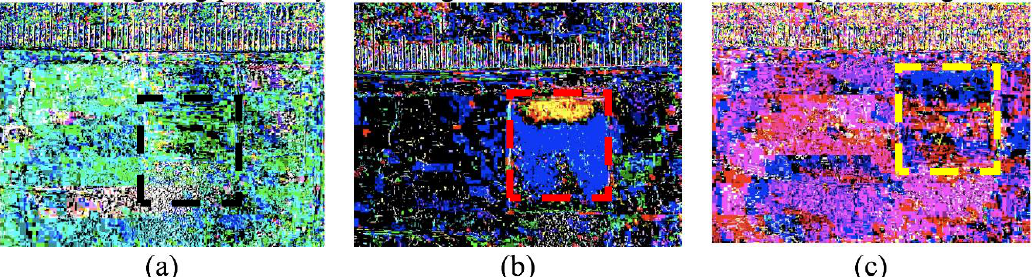
Figure 4. This figure shows the mixing of three combinations of two solutions. All images are the first frame in a 900-frame sequence, each subtracted from their respective final frame for a lapse-time of 15 min. The background and ruler are given for contrasting any changes that may occur in the porous swellable pad. The gauze pads are highlighted by dashed lines for easier visualization. The images are as follows: ( a ) Initially contains 100% water followed by 100% water, which exhibits no change in the pad; ( b ) Initially contains 50/50% glycerol followed by 100% water, which displays two lobes in blue and a region of yellow due to Korteweg stresses and viscous fingering; ( c ) Initially contains 100% glycerol followed by 100% water, which demonstrates that the initial 100% glycerol is too viscous to penetrate the pores in the pad.